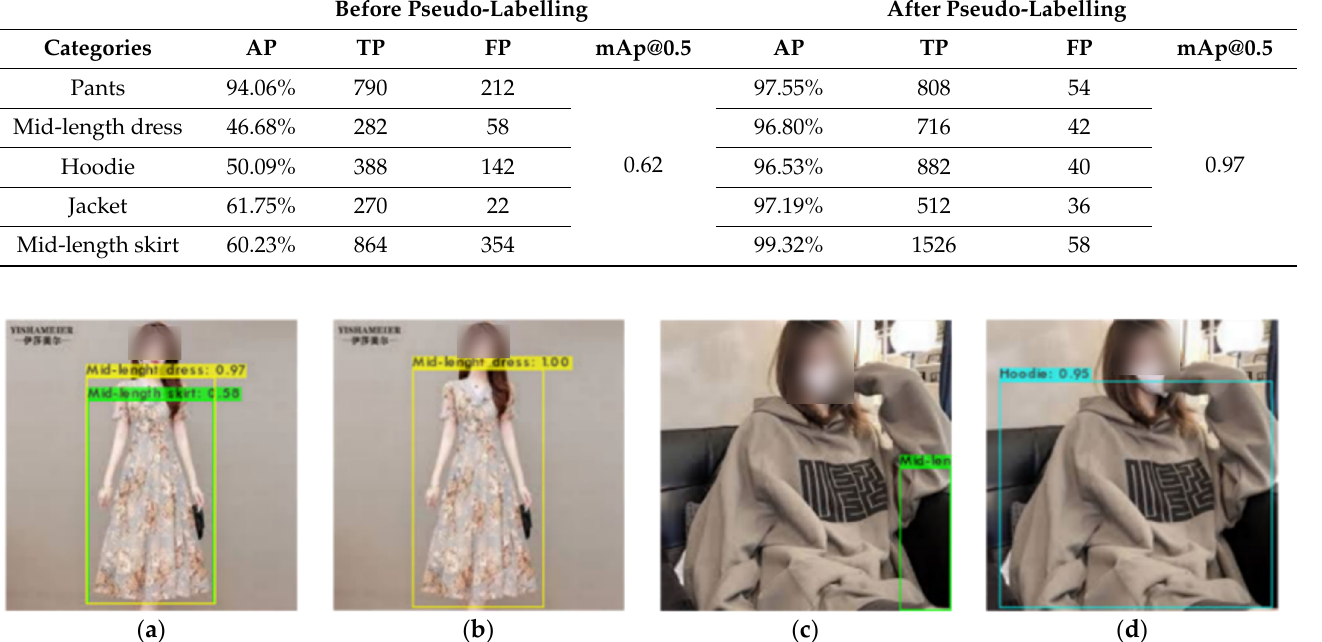
( d ) Figure 12. Detection results with different augmentation results. ( a ) Result After Training with Dataset B; ( b ) Result After Training with Dataset C; ( c ) Result After Training with Dataset D; ( d ) Result After Training with Dataset E.